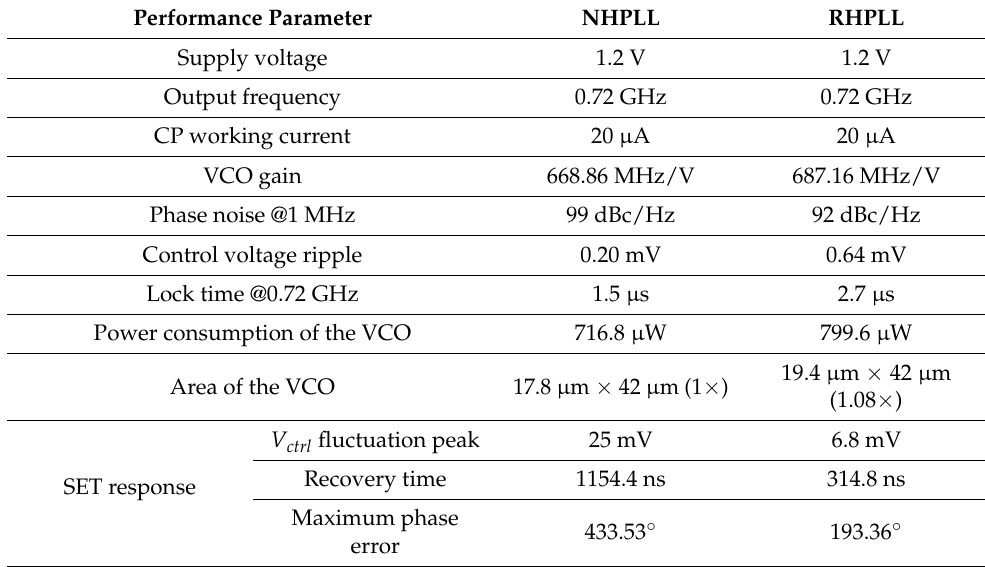
Table 1. Performance comparison of the PLL before and after hardening.